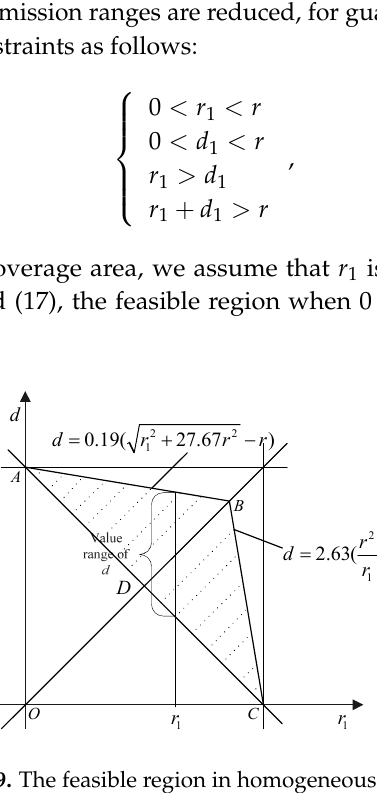
Figure 9. The feasible region in homogeneous networks.